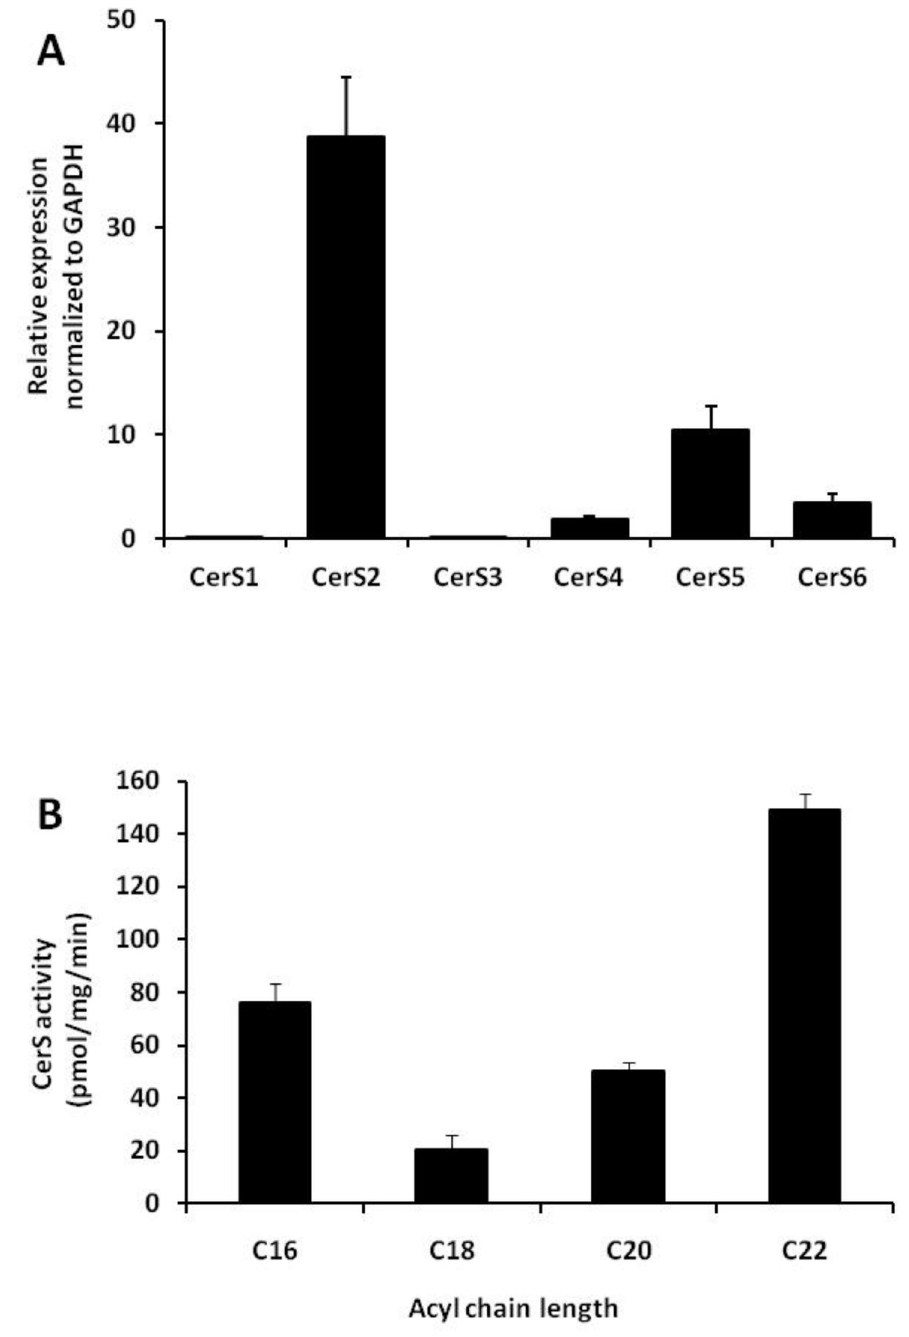
Figure 2. CerS expression and endogenous CerS activity in RAW 264.7 cells. (A) RAW 264.7 cells were harvested and cDNA was synthesized. CerS mRNA levels were measured by RT-qPCR as described under “Experimental Procedures”. The data are normalized to GAPDH mRNA expression and data are means ± S.E. for three independent experiments performed in triplicate. (B) CerS activity was assayed in cell homogenates using C “Experimental Procedure”. Results are means ± S.E. for four independent experiments.